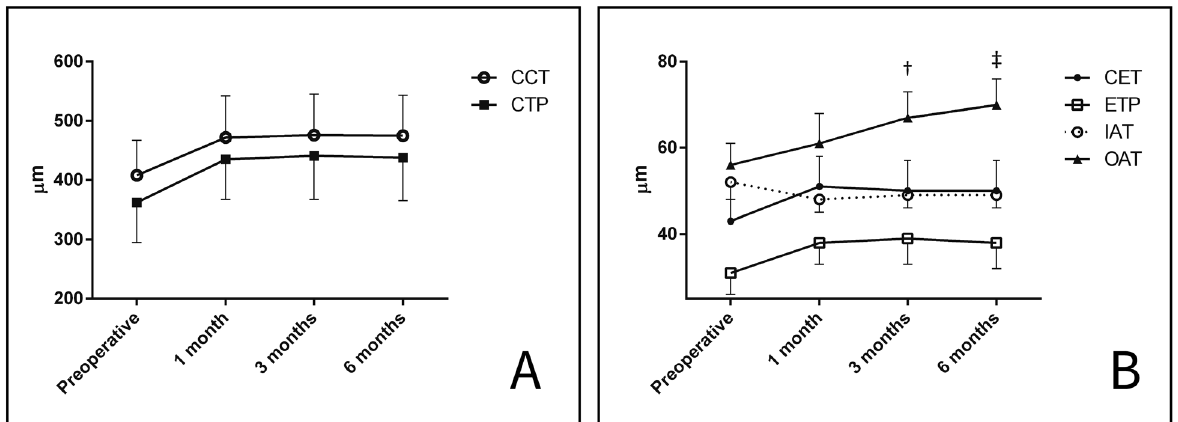
Figure 3. Corneal and epithelial thickness changes over time. Central corneal thickness (CCT) and Corneal thinnest point (CTP) significantly increased 1 month after surgery (panel A ) and remained stable thereafter. Significant modifications of central epithelial thickness (CET), epithelial thinnest point (ETP), mean inner annular area thickness (IAT), and mean outer annular area thickness (OAT) were reported between preoperative and 1 month (panel B ). OAT significantly increased also at 3 months (†) and 6